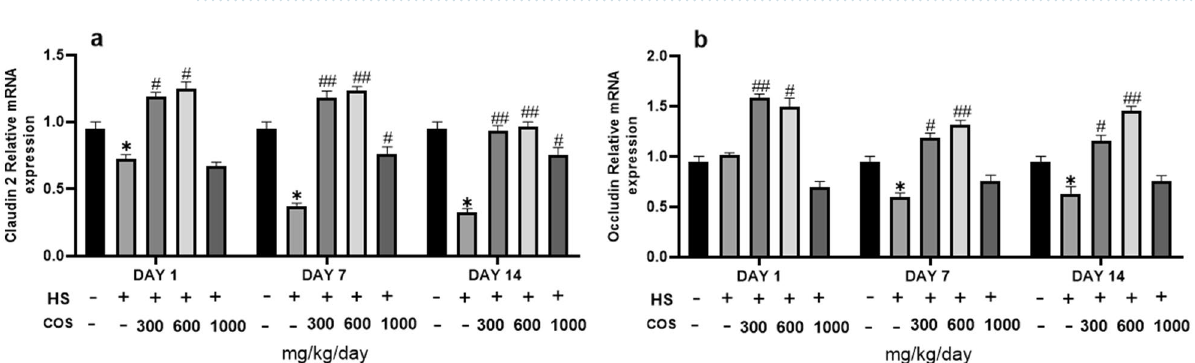
Figure 8. Effects of chitosan on protein expression of IL-10 and TNF-α. Control: normal mice; HS: Heat stress mice; COS-LD: mice treated with HS plus COS (300 mg/kg); COS-MD: mice treated with HS plus COS (600 mg/kg); COS-HD: mice treated with HS plus COS (1000 mg/kg). Data are expressed as mean ± standard error. *Indicates p < 0.05 compared with the blank control group, # Indicates p < 0.05 compared with the HS control group.